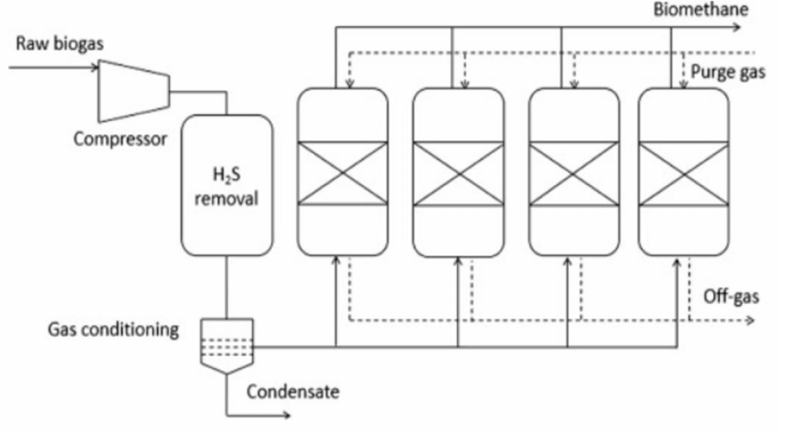
Figure 6. Process diagram for PSA system [23]. Reprinted/adapted with permission from Ref. [23]. Copyright 2022,